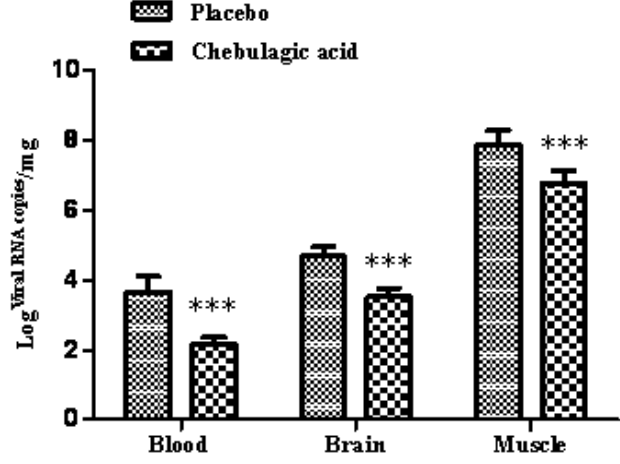
Figure 5. Chebulagic acid treatment inhibited the replication of EV71 in different tissues of the mice. The infected mice were treated with the placebo or with chebulagic acid at a dose of 1 mg/kg. The tissues were sampled and subjected to viral RNA copy analysis by qRT-PCR at 6 dpi, respectively ( n = 8). The data are expressed as the mean values of three independent experiments (*** p < 0.005).